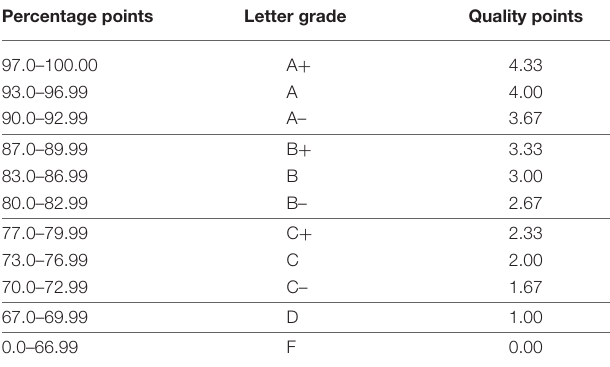
TABLE 1 | Current PL100 grading scale at USMA and quality point